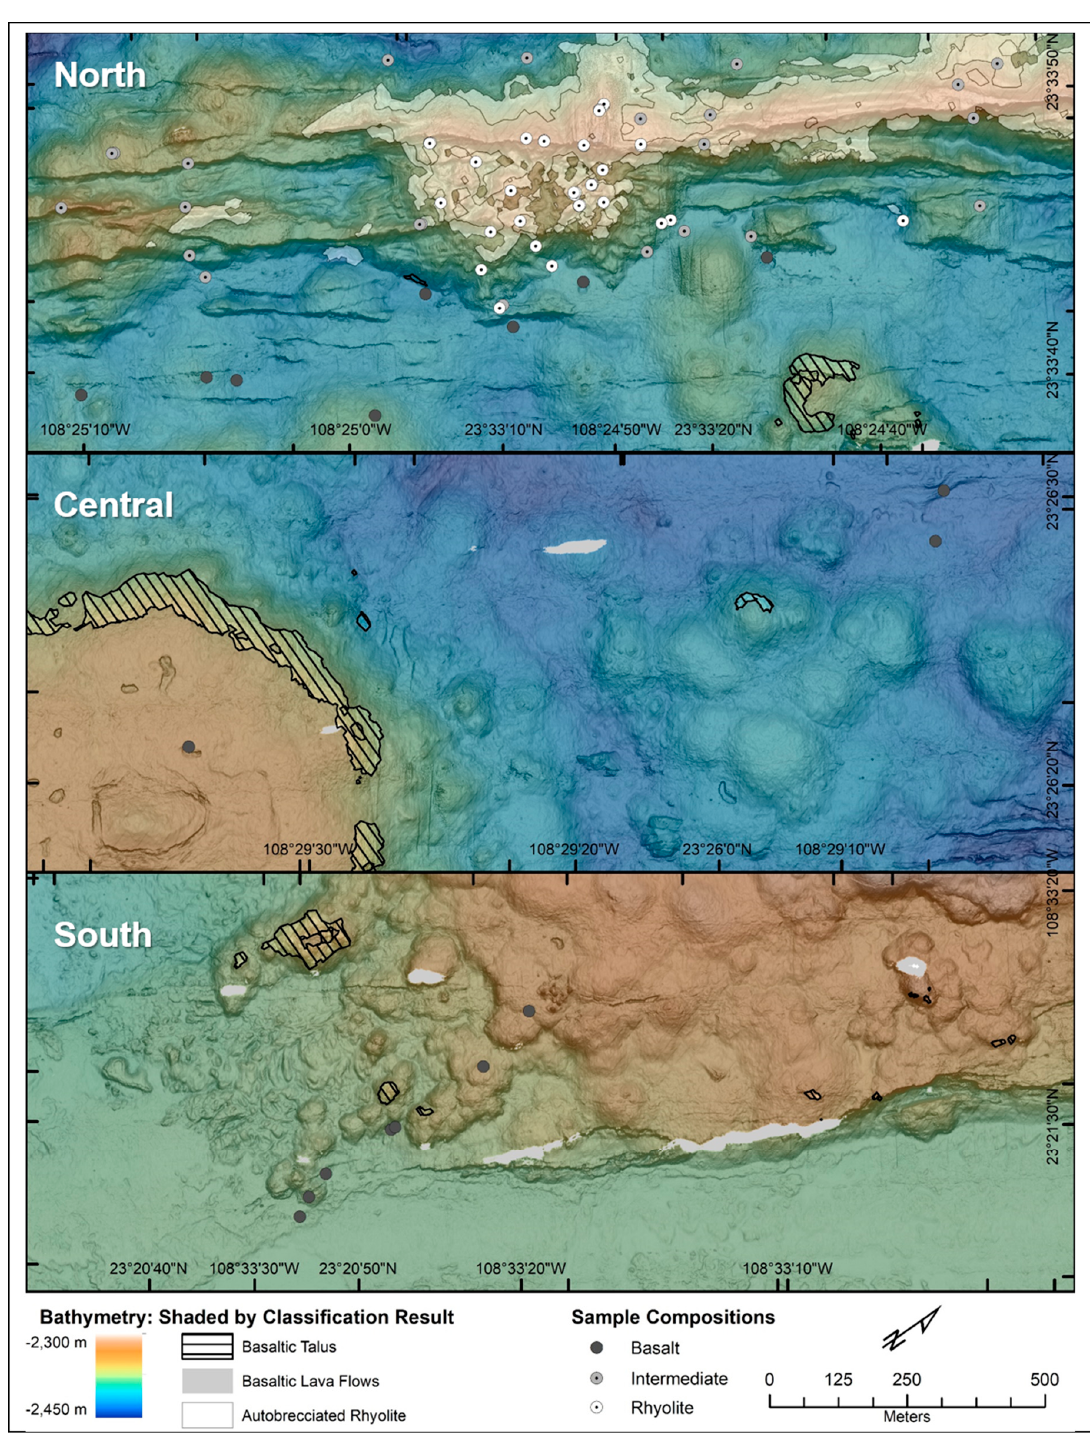
Figure 12. Classified map of the Alarcon Rise in three geomorphologic regions with testing data. The north region contains the majority of lava flows classified as rhyolite. The west side of the ridge also has a distinctly rhyolitic lava morphology compared to seafloor east of the ridge. The majority of the rhyolitic dome was classified with rhyolitic compositions. The central region was mostly classified as basalt. One notable exception is the edge of the volcanic cone. This is likely due to brecciated lava flows and talus at the steep sides. ANFIS correctly classified the southern lava shield as basaltic.